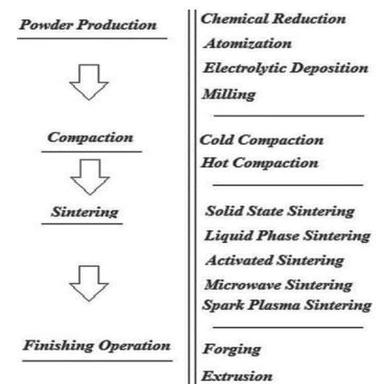
Powder Metallurgy Techniques.